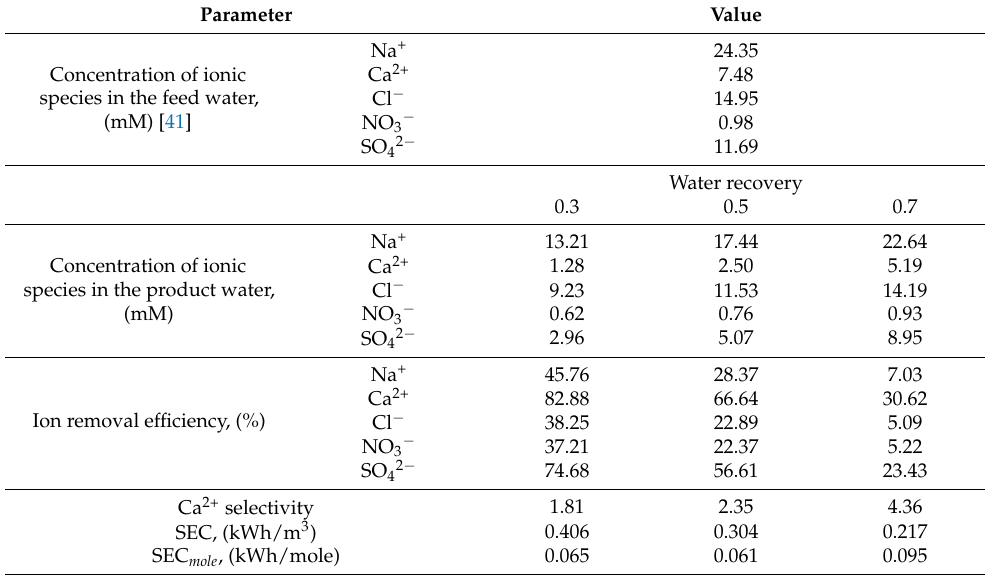
Table 3. Water softening performance and energy behaviors of quasi-steady state MCDI for par- tially softening industrial cooling tower blowdown water.